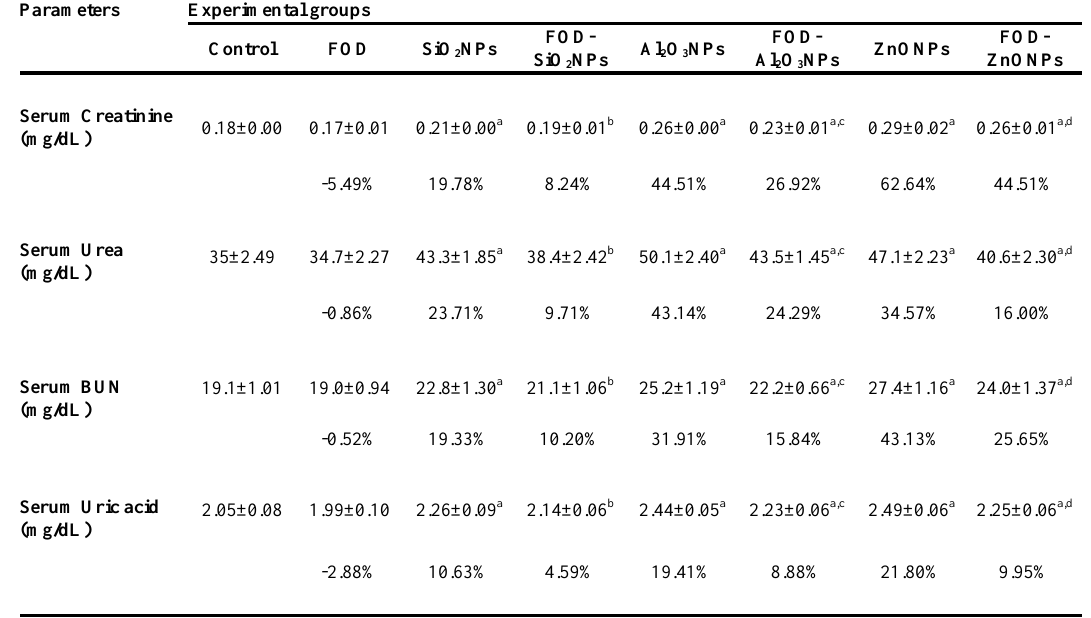
Table 3. The effects of fig with olive oil and date-palm fruit extract on the serum kidney function parameters of male rats treated with silicon oxide nanoparticles, aluminum oxide nanoparticles, or zinc oxide nanoparticles